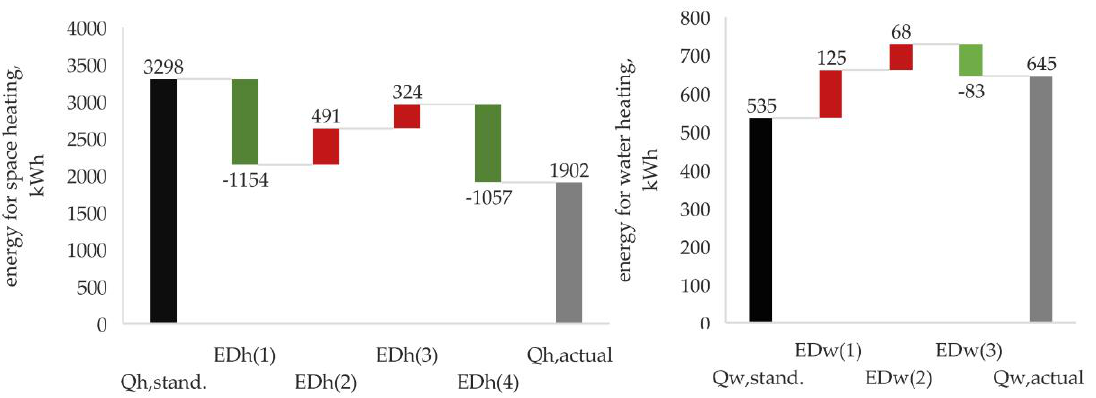
Figure 9. Influence of individual parameters on the values of energy consumption for heating ( Q h ) and hot water preparation ( Q w ) for unit E.